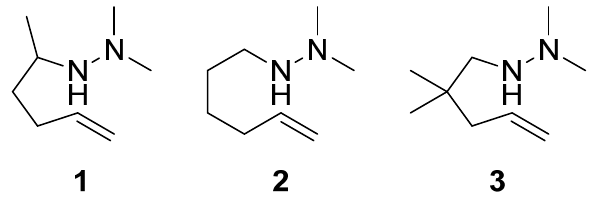
Figure 2. N,N-dimethylhydrazinoalkenes used in this study.